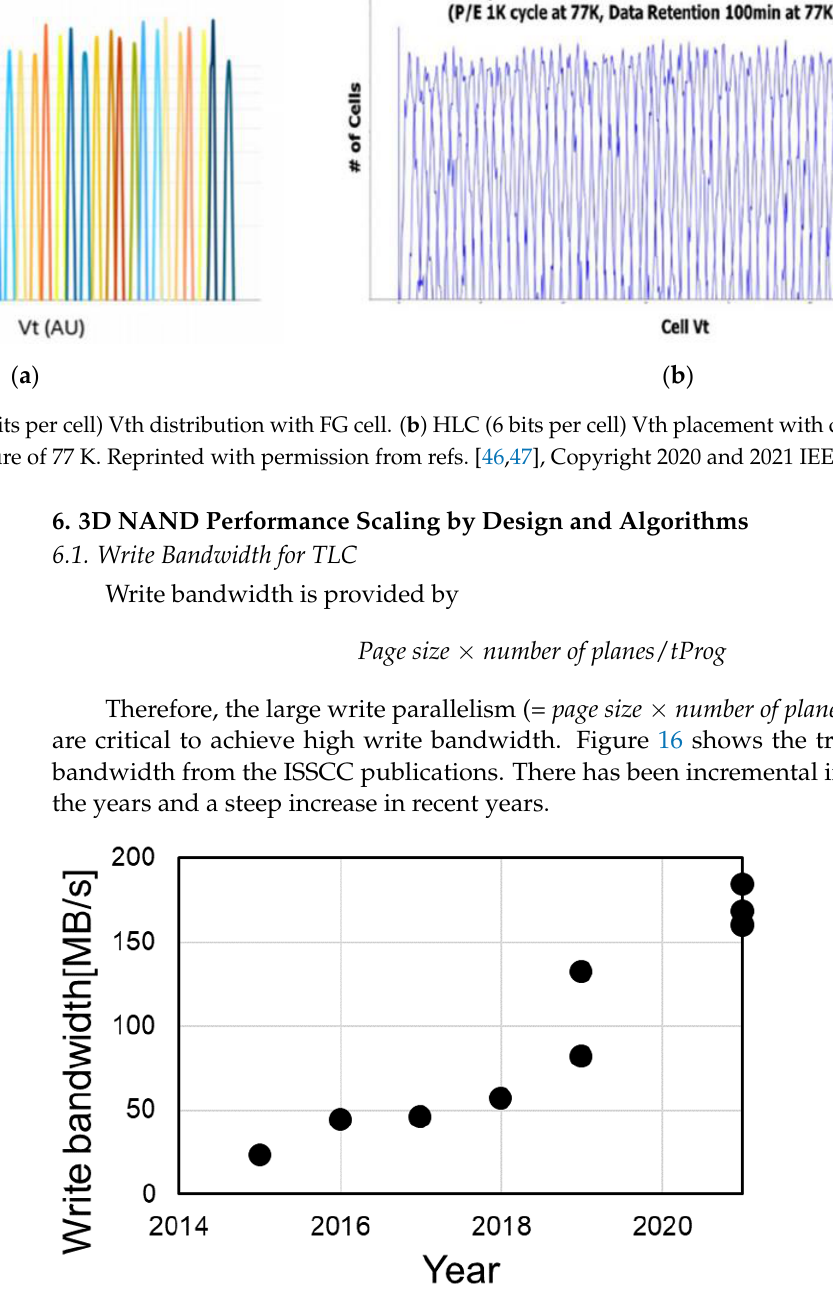
Figure 14. 3D NAND publications in ISSCC for SLC, MLC, TLC and QLC technologies. TLC has been the mainstream for 3D NAND. The interest in QLC is rapidly increasing.